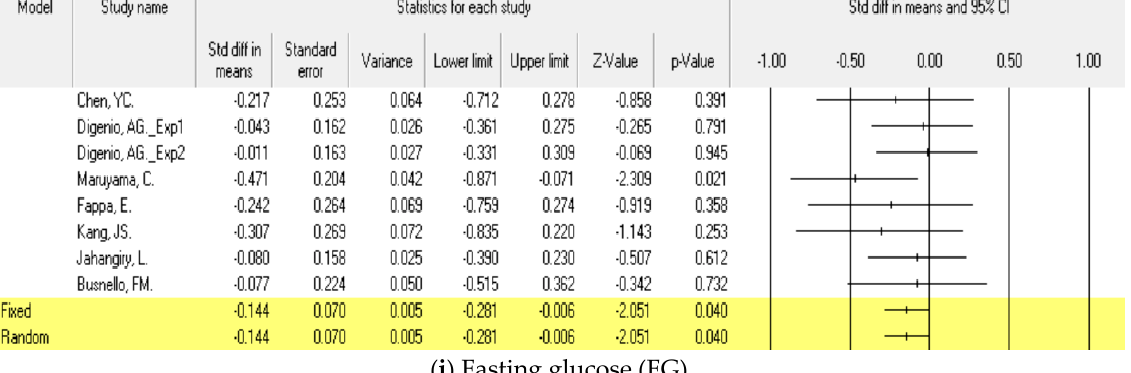
Figure 3. Forest plot of the meta-analysis for technology-mediated intervention on prevention of metabolic syndrome. Each study is identified by first author. The individual effect sizes are identified as “standardized mean difference” with lower and upper limits (95% confidence intervals). The overall summary effect size of the meta-analysis is noted as a diamond on the bottom line.